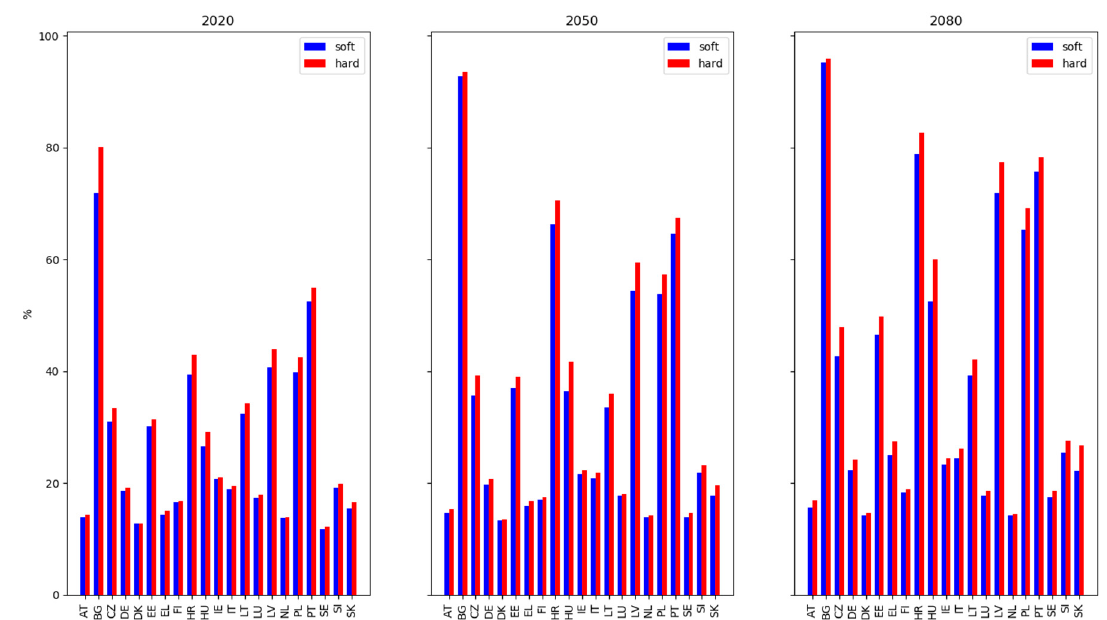
Figure 4. The percentage of the population that cannot afford insurance under soft market conditions (blue) and hard conditions (red) for EU countries, in 2020, 2050, and 2080, for RCP4.5. Countries that provide public reinsurance for flood insurance are excluded here, as these are not exposed to global reinsurance market volatility resulting from large natural catastrophes.